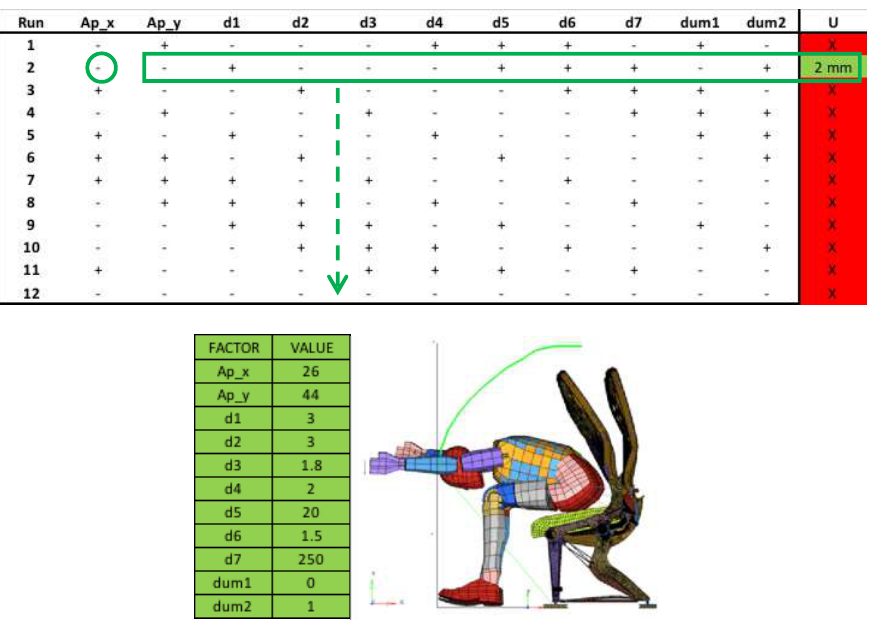
Figure 9. Results of the second round of numerical experiments.